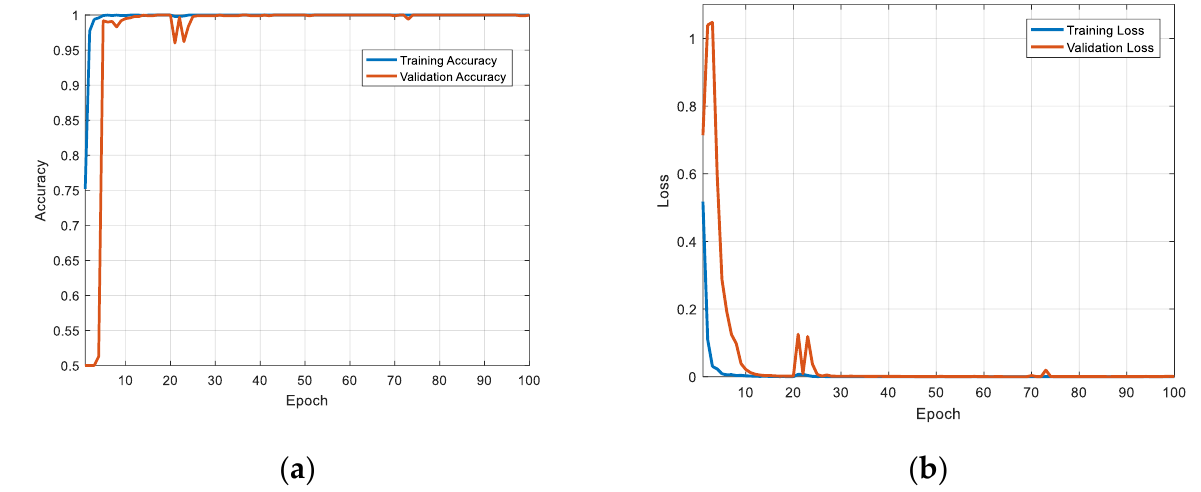
Figure 9. ( a ) The training/verification accuracy curve and ( b ) the training/verification loss curve of image block 20 × 20 in the case of 0 dB SNR.